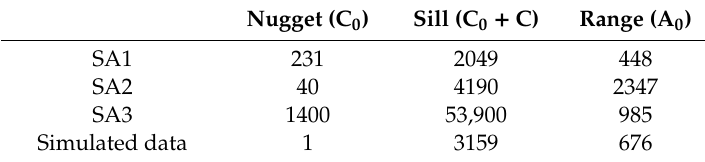
Table 2. Parameters (in meters) of semivariograms of three study areas and simulated data.